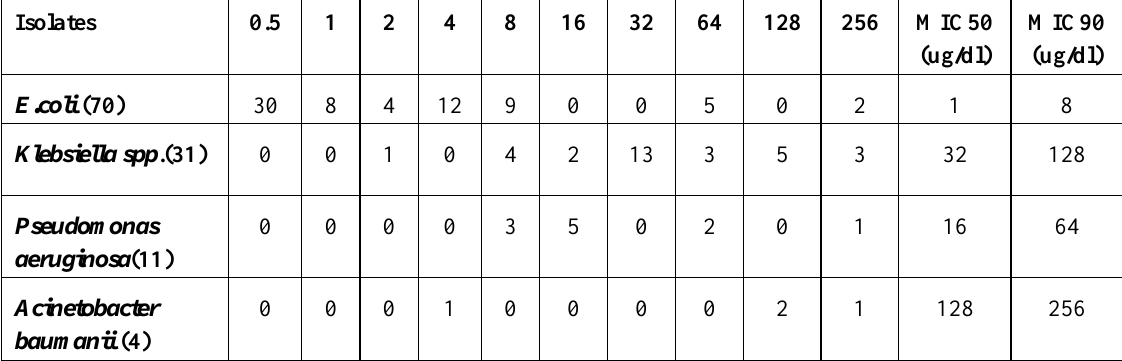
Table 4. Minimum inhibitory concentration (MIC) distribution and susceptibility rates of Fosfomycin by agar dilution method against different bacterial isolates.